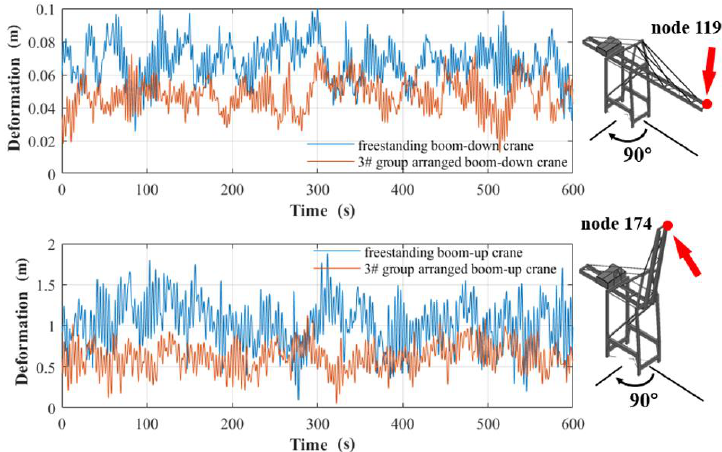
Figure 20. Displacement response time history of the node at the end of jib for both states ( α = 90°, S / H = 0.484).